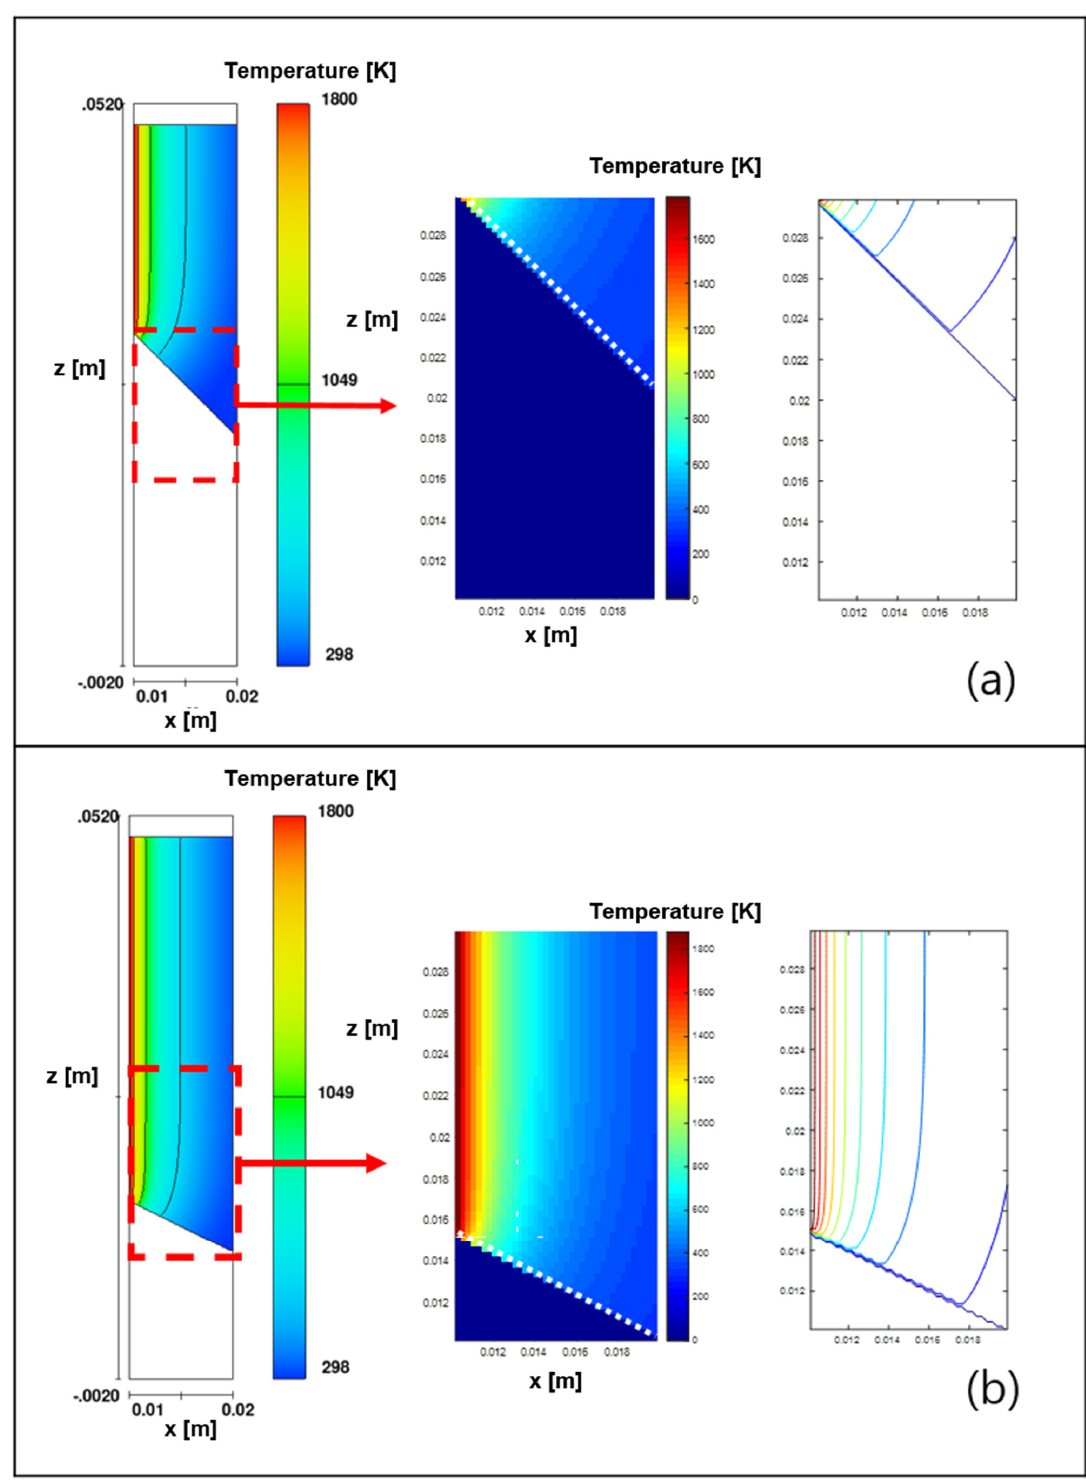
Figure 13. Laser cutting simulation results ( a ) Enlarged section of case 2 ( b ) enlarged section of case 4.